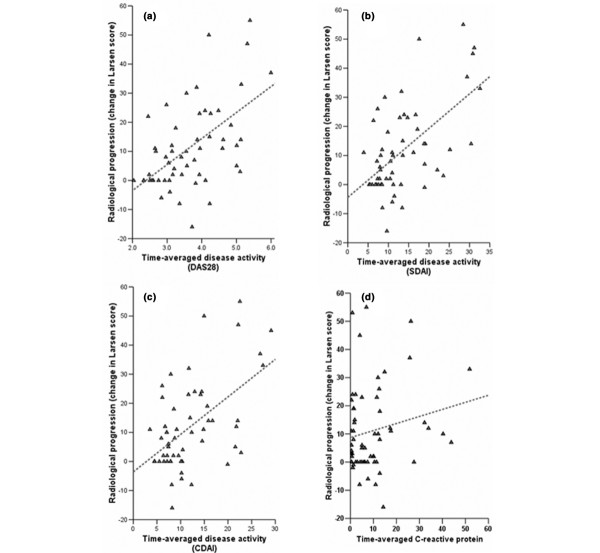
Association of composite scores with radiological outcome. Correlation with changes in Larsen scores within 3 years from entering the inception cohort (n = 56) of time-averaged (a) Disease Activity Score (DAS)28 (R = 0.58, 95% confidence interval [CI] 0.37–0.73), (b) Simplified Disease Activity Index (SDAI; R = 0.59, 95% CI 0.39–0.74), and (c) Clinical Disease Activity Index (CDAI; R = 0.54, 95% CI 0.32–0.70). All correlations are significant (P < 0.0001). (d) C-rectaive protein (CRP; R = 0.28, 95% CI 0.02 to 0.51; P = 0.025).